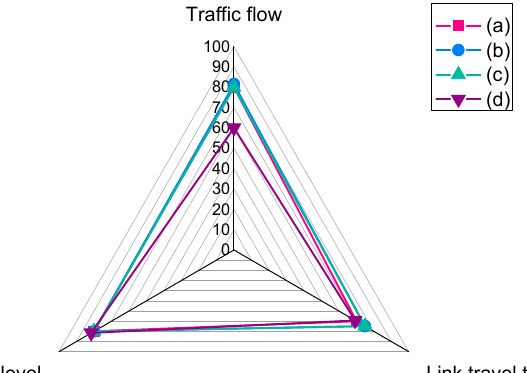
Figure 9. Evaluation results of road network.